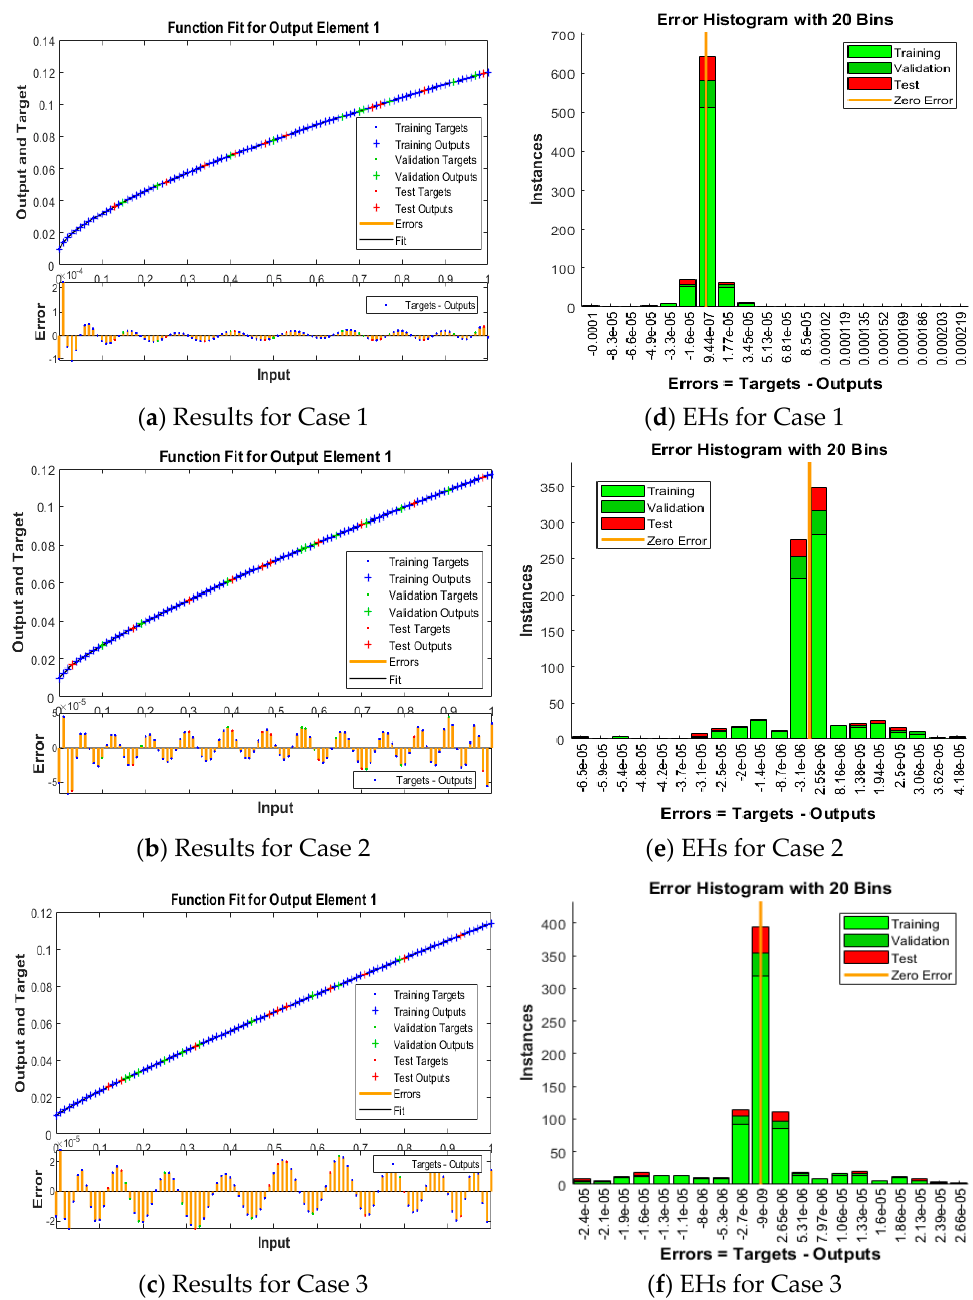
Figure 3. MSE values and ST performances to solve the fractional monkeypox infection mathemat- ical model.